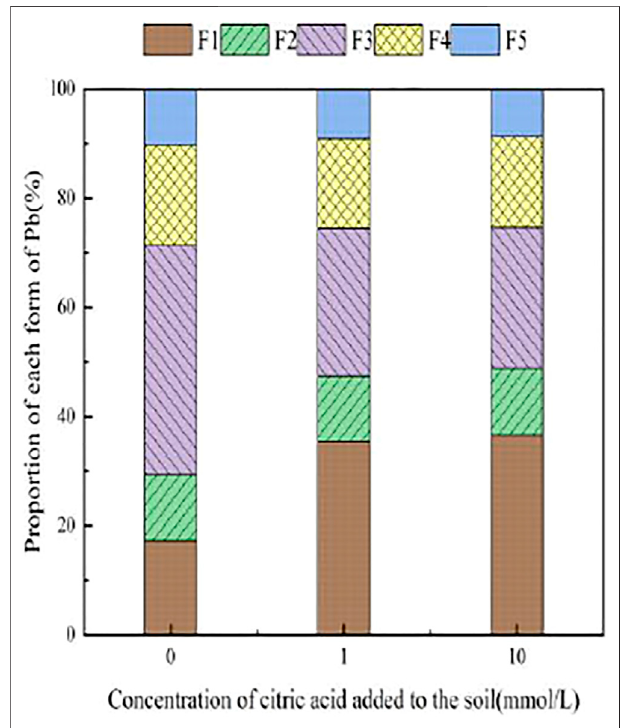
FIGURE 5 | Distribution of Pb form in